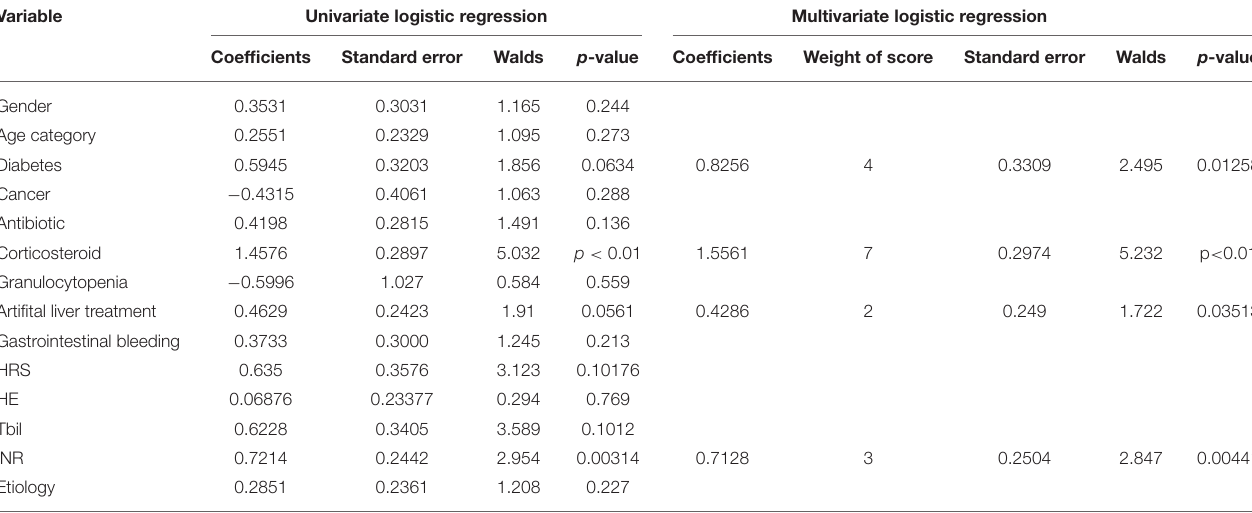
TABLE 2 | Multivariate logistic regression analysis of risk factors associated with invasive pulmonary aspergillosis (IPA) development in the training dataset.